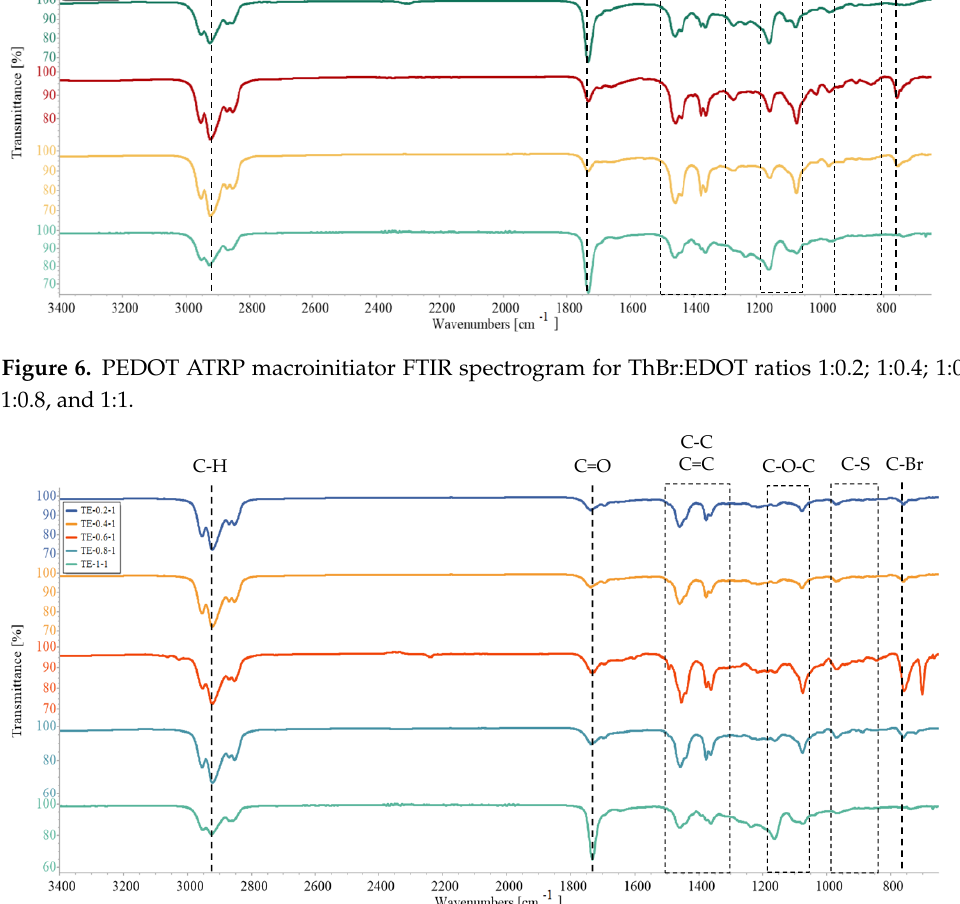
Figure 7. PEDOT ATRP macroinitiator FTIR spectrogram for ThBr:EDOT ratios 0.2:1; 0.4:1; 0.6:1; 0.8:1, and 1:1.